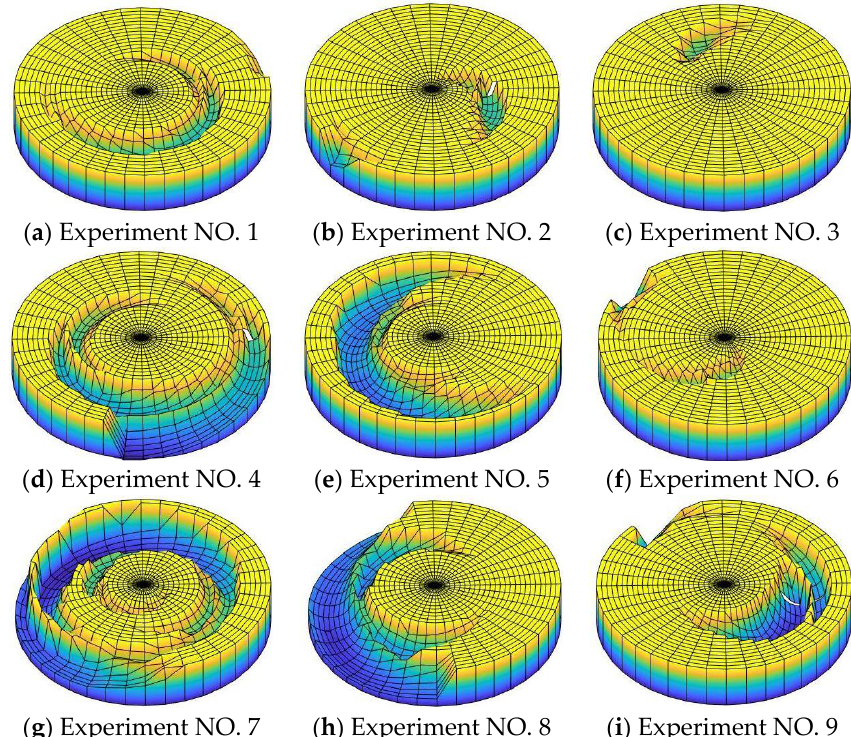
Figure 32. Scratch damage morphology on the workpiece surface with experimental parameters.